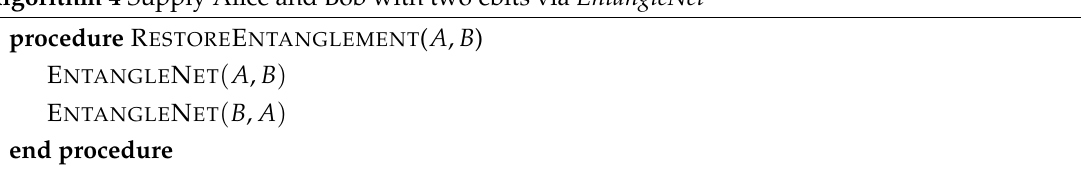
Algorithm 4 Supply Alice and Bob with two ebits via